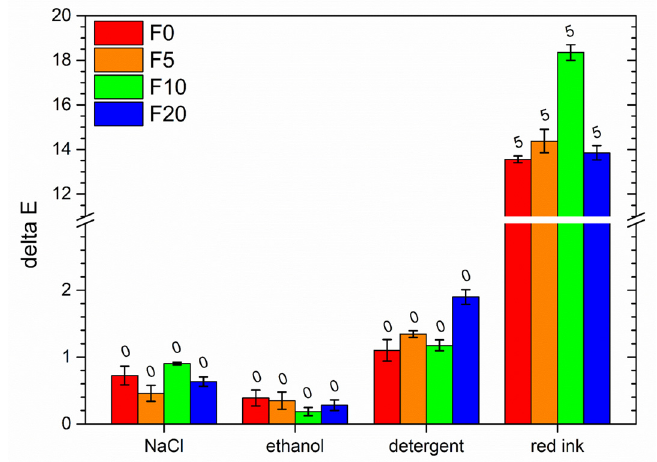
Figure 8. Coatings color changes of the samples after contact with liquids. The numbers above the columns are representative of the discoloration levels reported in Table 3.